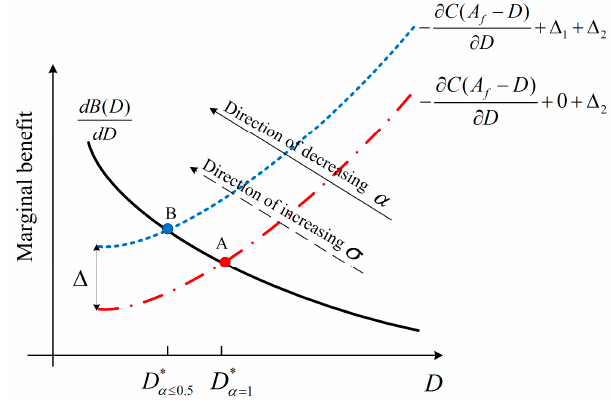
Figure 2. Equilibriums under expectation and CVaR criteria for optimal water delivery.